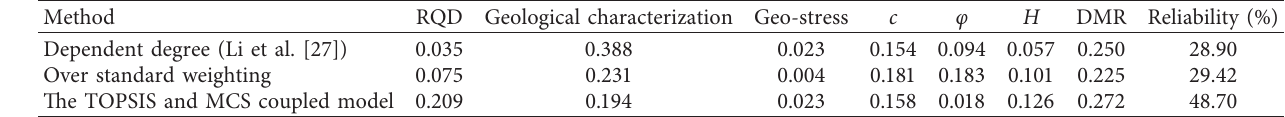
Table 3: Reliability comparison of different weight methods.